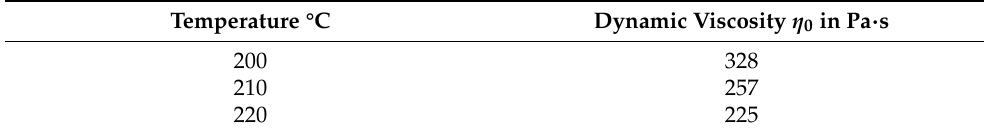
Table 5. Dynamic viscosity η 0 of PP for the three different temperature levels.